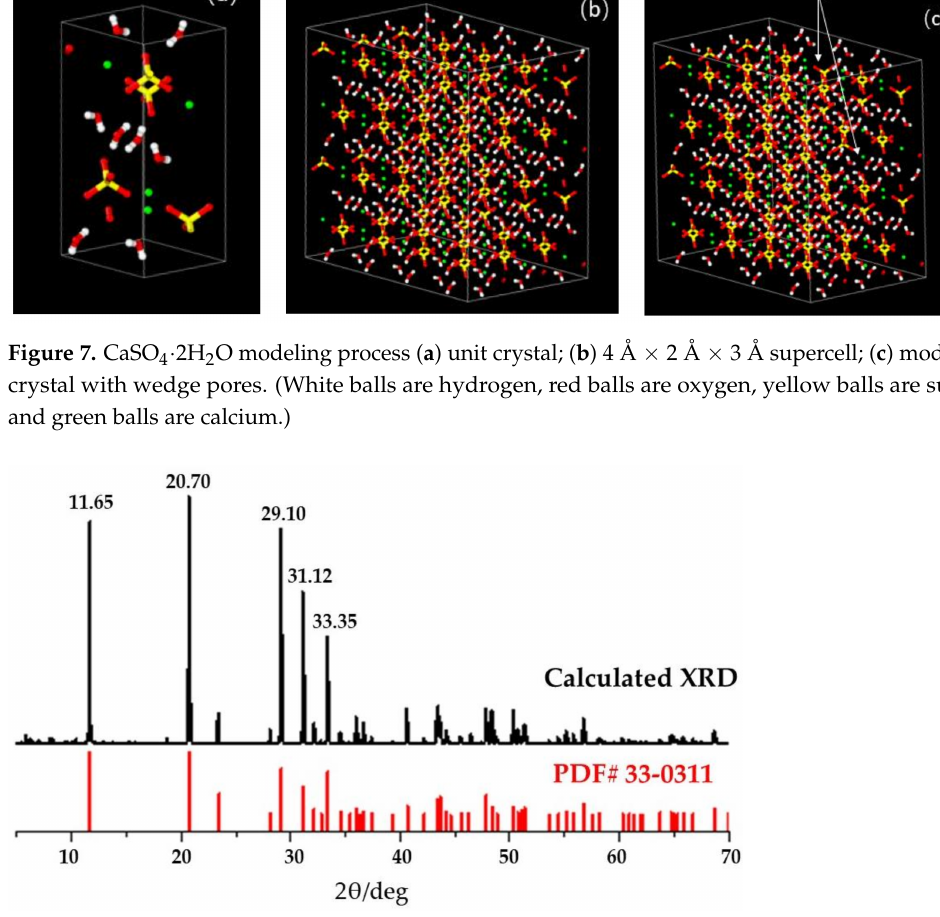
Figure 8. XRD pattern of the CaSO 4 · 2H 2 O